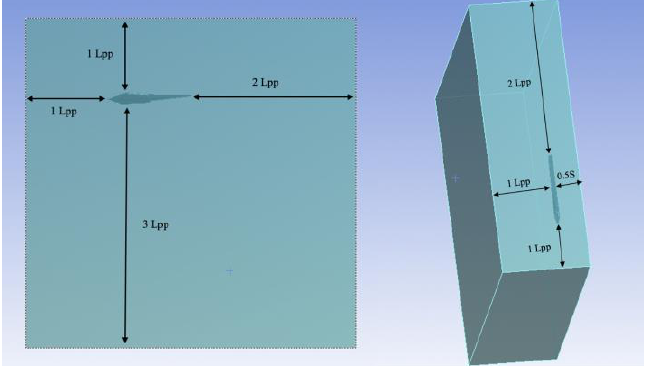
Figure 6. The computational domain of the applied velocity condition, and free surfaces. Table 3. Boundary location for computational fluid dynamics.